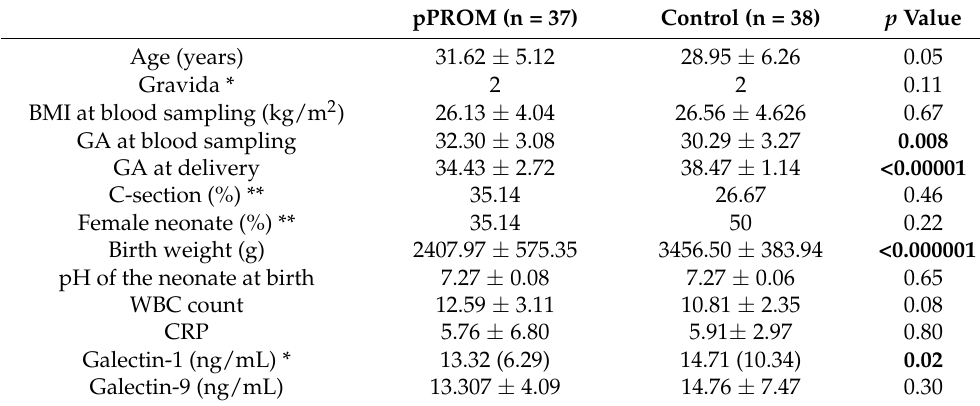
Table 1. Demographic and clinical characteristics of the study